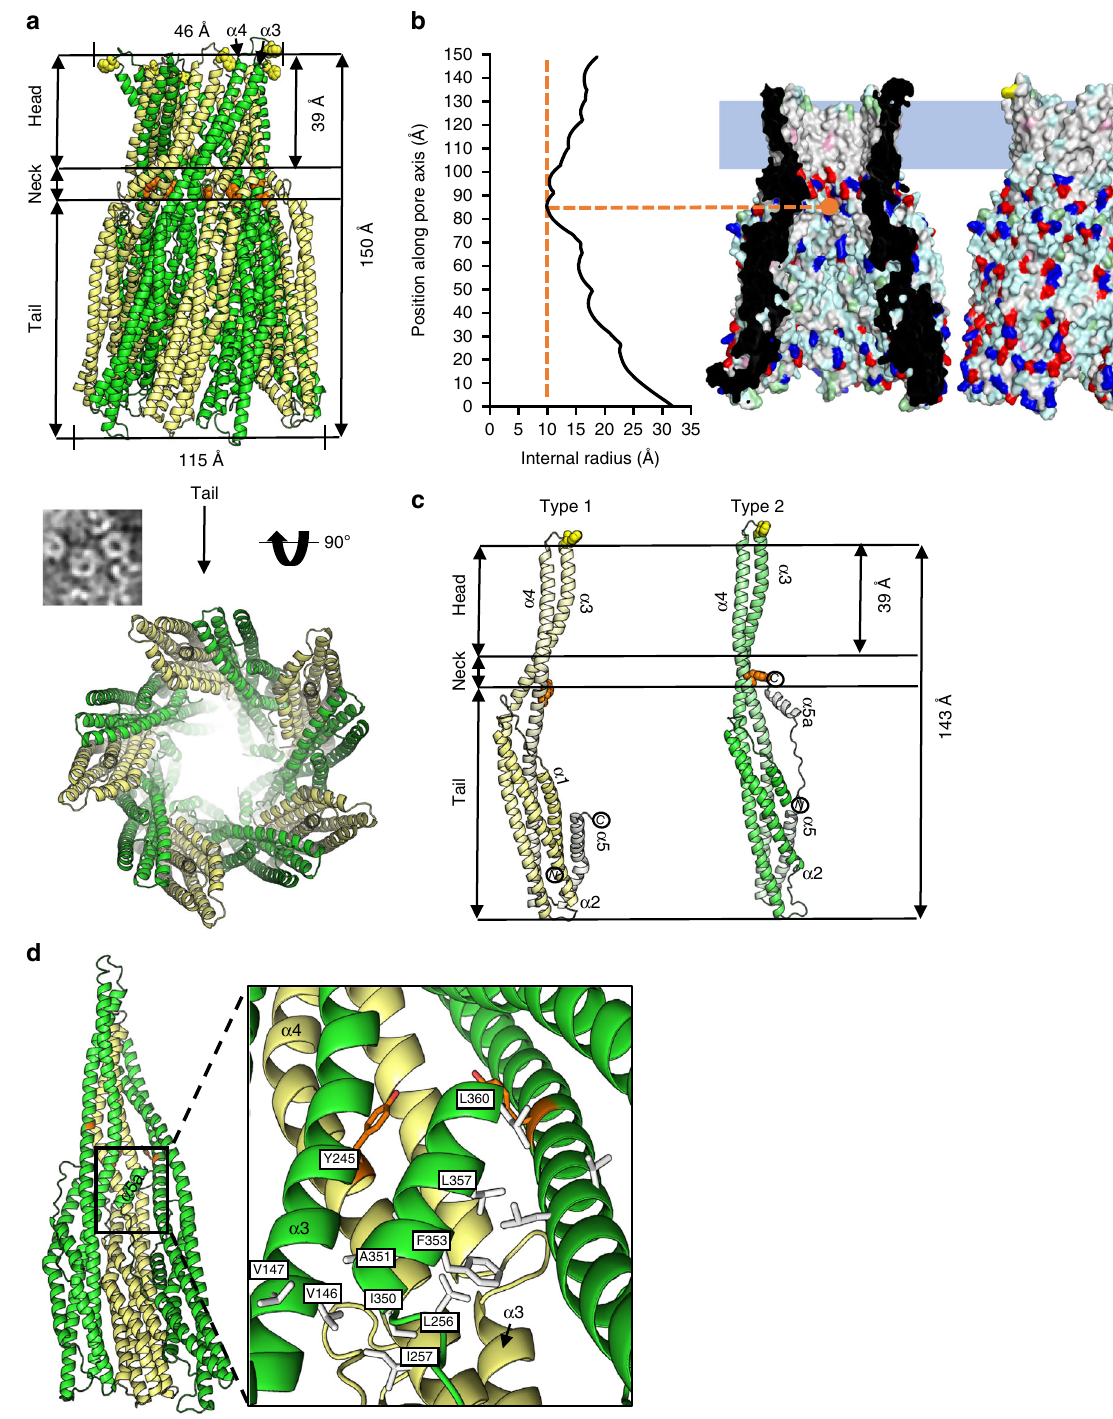
Fig. 3 Structure of the AhlB pore. a Cartoon representation of AhlB pore, Type1 conformation is pale yellow while Type 2 is coloured green. Y245 is shown as orange spheres and delineates the beginning of the hydrophobic head, with the ring of F203 highlighted as yellow spheres at the end of the head. Below is a negative stain EM image of AhlB pores in liposomes next to the crystal structure, orientated as seen in the EM, with the a view looking down the pore from the tail. b Surface rendering generated in PyMOL 61 , shows hydrophobic (white), negative (red), positive (blue) and polar (cyan) surfaces. The membrane bound head domain is entirely hydrophobic, with a blue rectangle de fi ning the proposed membrane region. The internal radius against position along the vertical pore axis is plotted with the narrowest region in the neck labelled, calculations were performed using HOLE 35 . c Side view of the AhlB Type 1 and Type 2 protomers. Protomers are coloured dark (N-terminus) to light (C-terminus). The Head, neck and tail are highlighted along with residues F203 and Y245 coloured as in ( a ). d Interactions between α 5a with the neighbouring subunits in the Type 1/Type 2 dimer, with hydrophobic residues highlighted in white and Y245 coloured